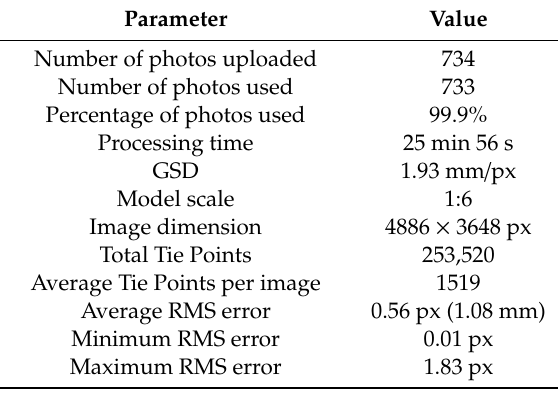
Table 3. Setting model parameters.